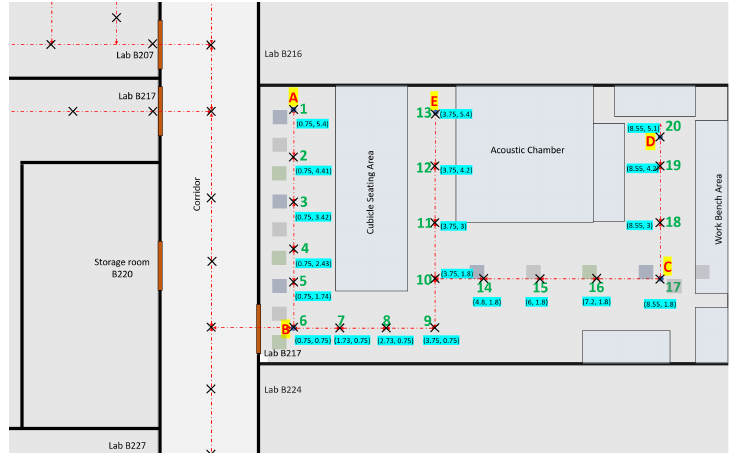
Figure 12. Measurement positions in ESPS Lab (B216) and surrounding